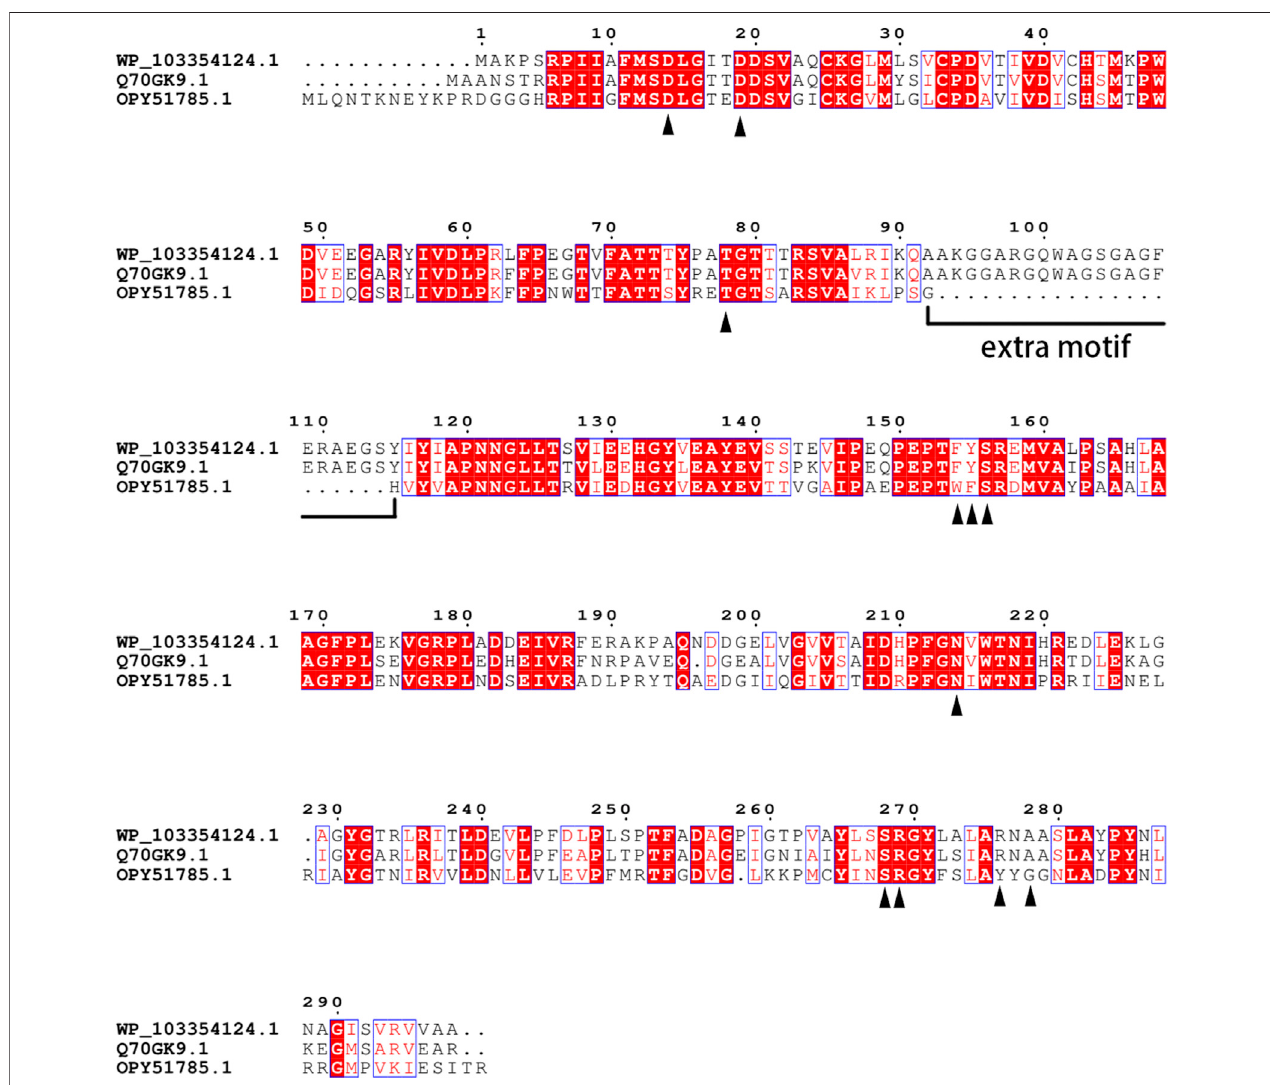
FIGURE 1 | Alignment of multiple amino acid sequences of FlA, Fme, and Fam. WP_103354124.1: Fam. Q70GK9.1: FlA. OPY51785.1: Fme. The amino acids in direct contact with the substrate were identi fi ed by the black triangle.